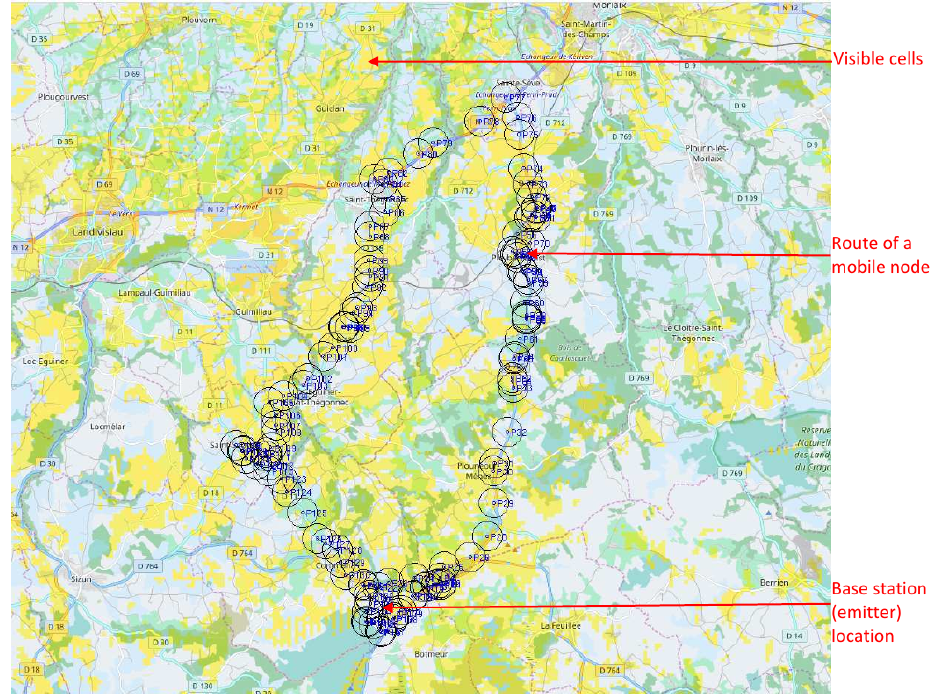
Figure A7. The base station (emitter) is located on top of the mountain (latitude: 48.4051306, longitude: − 3.9077762, elevation: 345 m). A receiver is placed on a car (receiver) traveling around the area with many hills, valleys, and big trees. From simulation results, places (cells) are able to receive the radio signal highlighted in yellow. Blue circles show points where the receiver successfully obtained messages in our actual measurement.